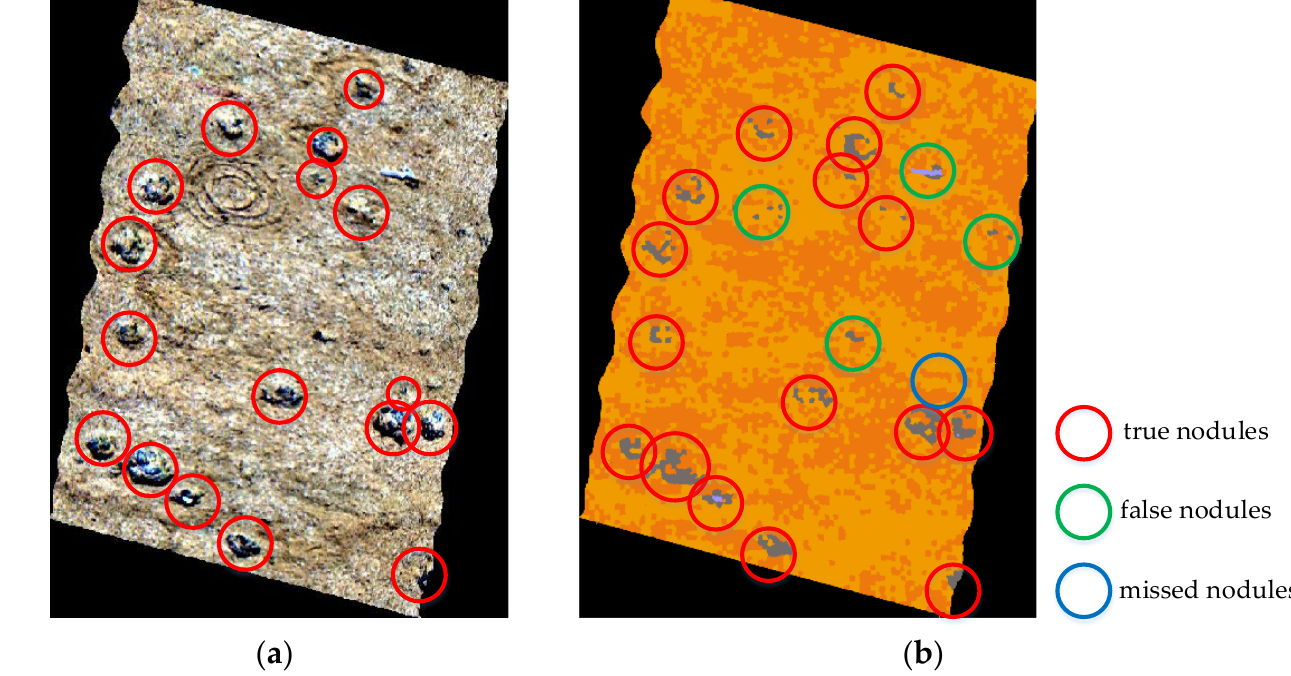
Figure 6. Analysis of manganese nodule clustering result. ( a ) real image ( b ) clustering image. The clustering results of the original hyperspectral pseudo-RGB image and Table 1. Experimental results.